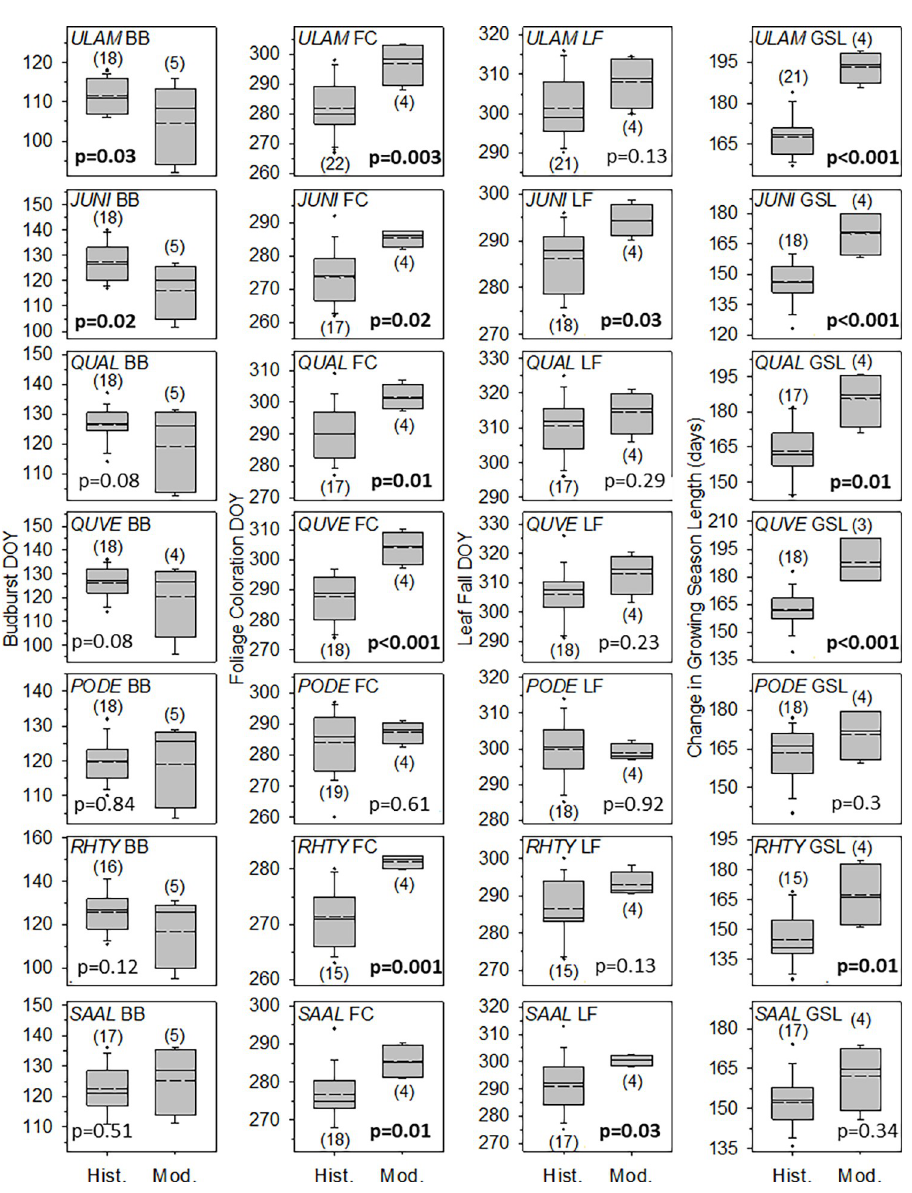
Fig 5. Comparison of historic versus modern timing of budburst, foliage coloration, and leaf fall, and growing season length for the seven focal species. Timing of each phenophase is given as the day of year (DOY) where 1 = Jan. 1 and 365 = Dec. 31. For each box, mean and median dates for each phenophase are indicated by dashed and solid lines, respectively, and outliers are indicated by points. Species abbreviations are ULAM = U . americana , JUNI = J . nigra , QUAL = Q . alba , QUVE = Q . velutina , PODE = P . deltoides , RHTY = R . typhina , and SAAL = S . albidum . Significant p -values are given in bold and sample sizes are given in